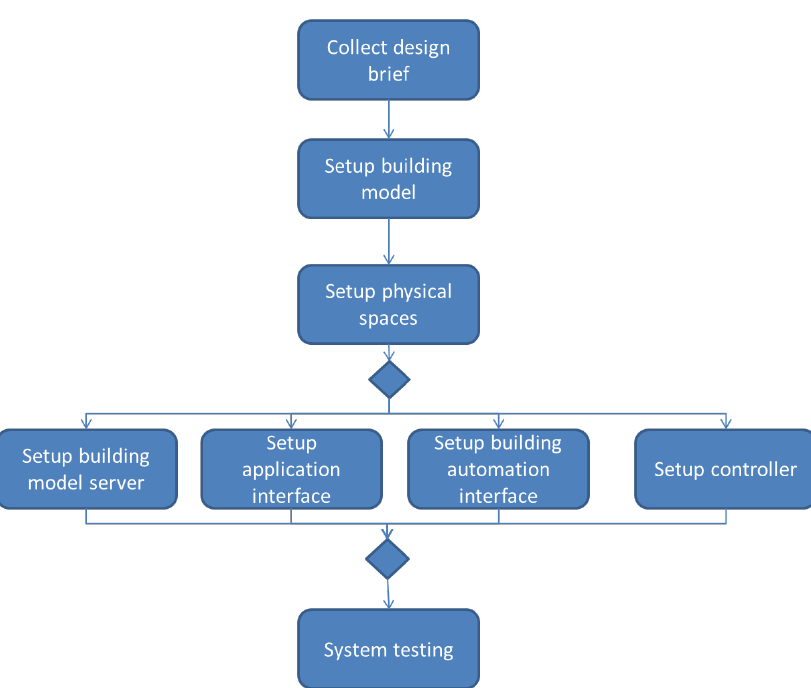
Figure 1. Top level view of the deployment